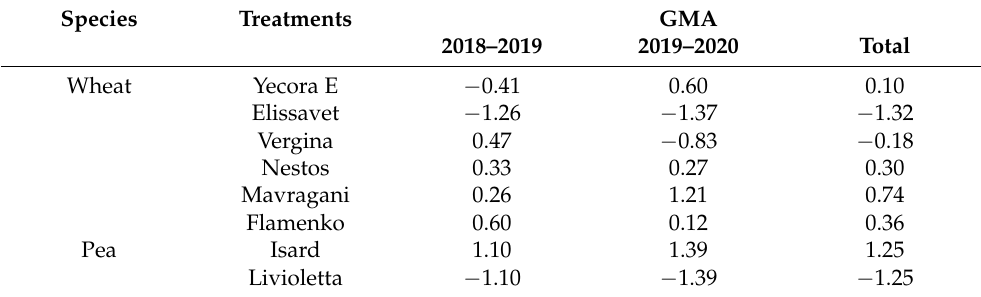
Table 6. General mixing ability (GMA) of wheat and pea varieties for the two growing seasons.